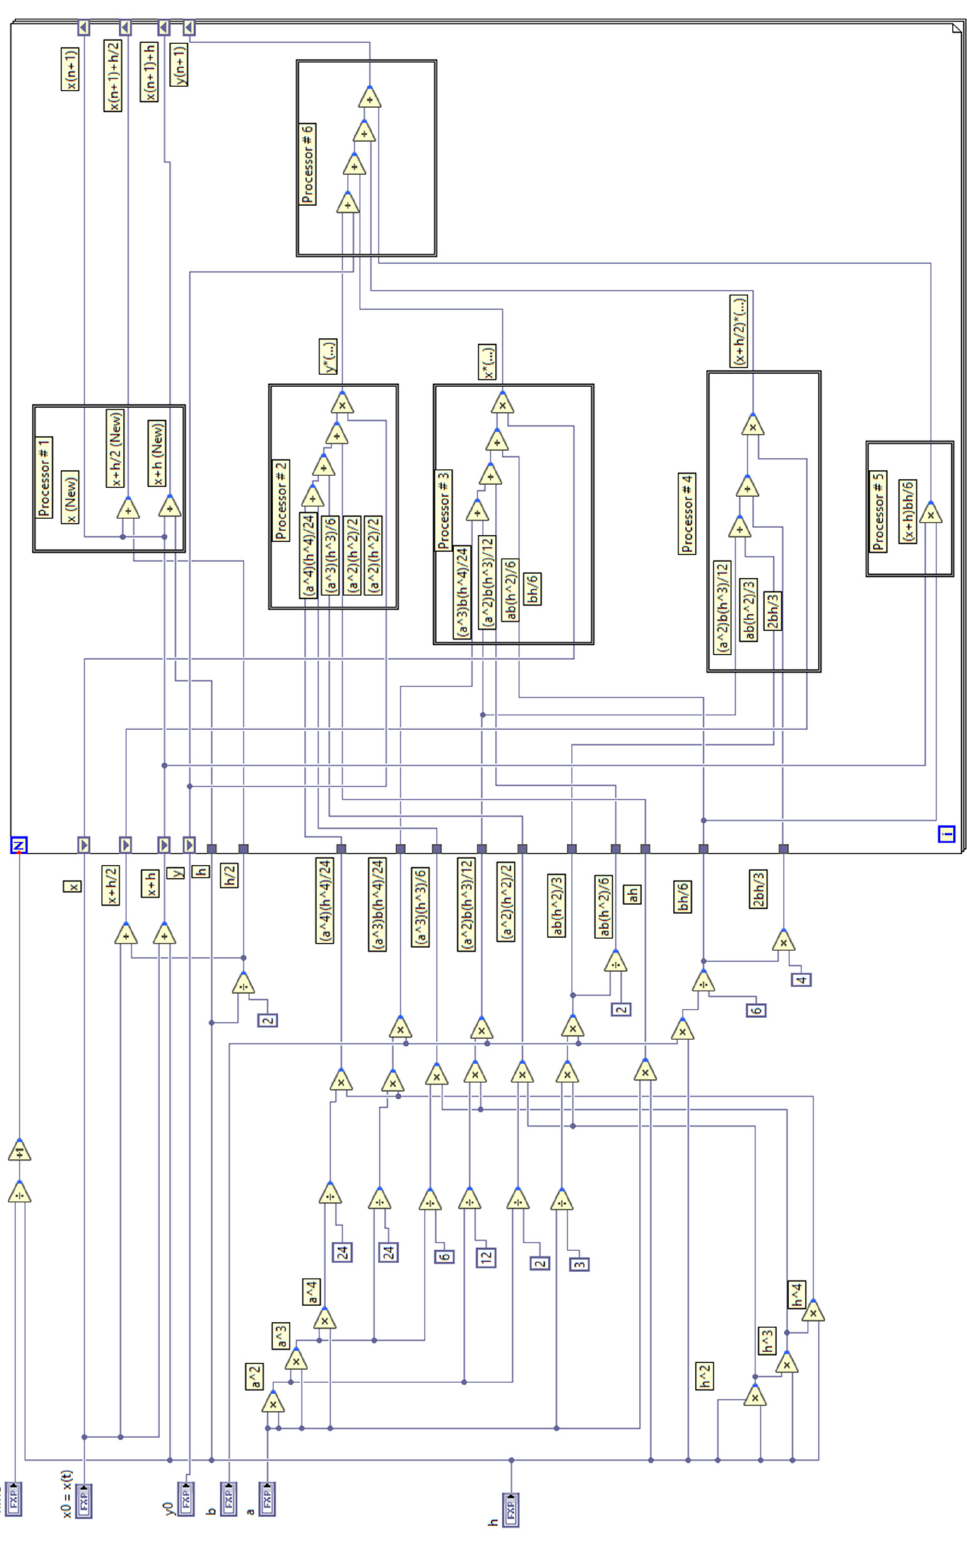
Figure A2. Graphical code of hardware FPGA ODE solver with multi-pipeline parallel computational structure for test problem (13). Fixed-Point data type with scaling.